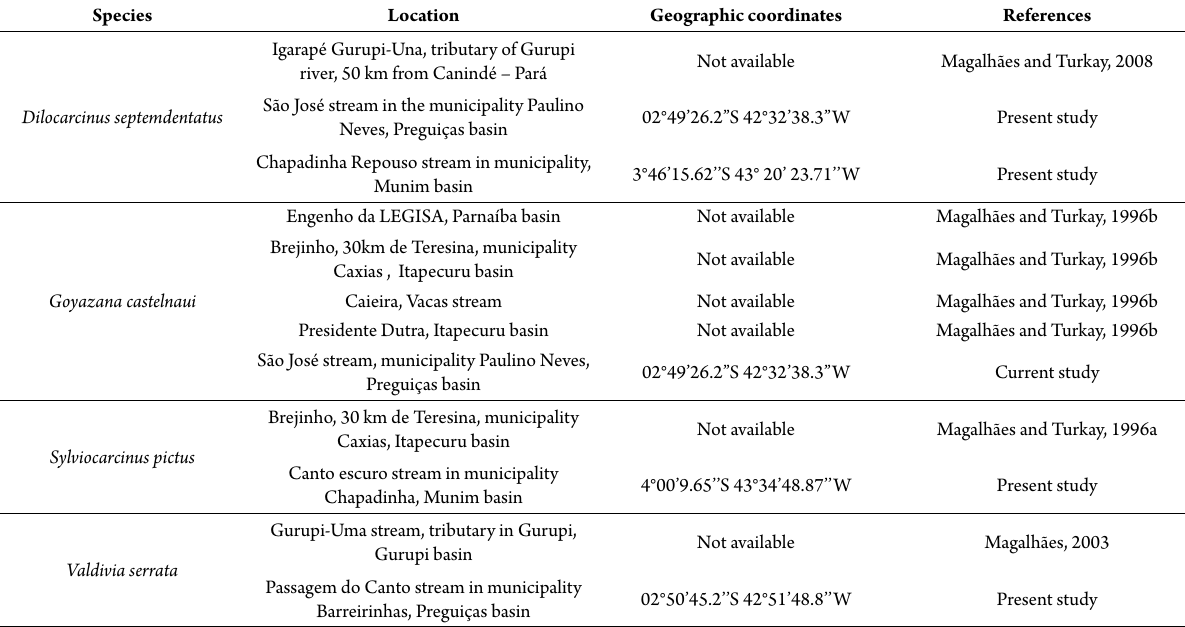
Table 1. List of the species of Trichodactylidae recorded from the state of Maranhão, Northeastern Brazil. Species Location Geographic